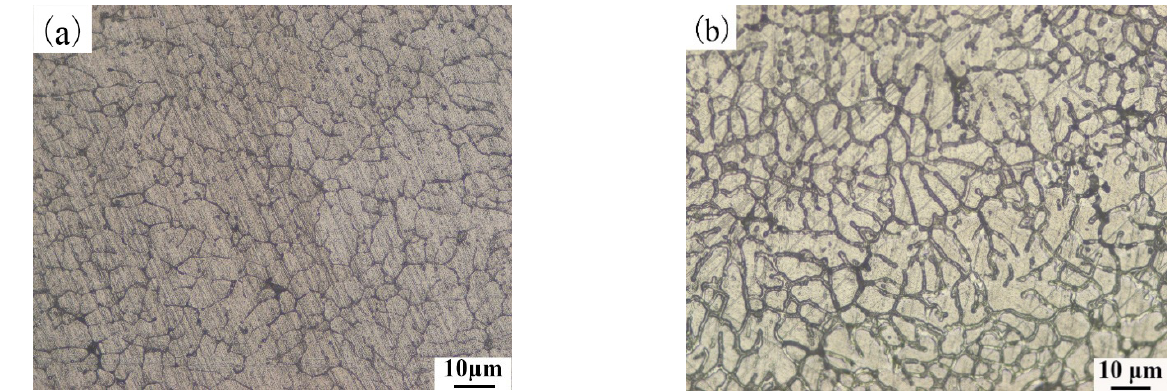
Figure 9. Metallographic structure for OABs with a 160 A overcurrent: ( a ) aluminum alloy wires; ( b ) aluminum wires.